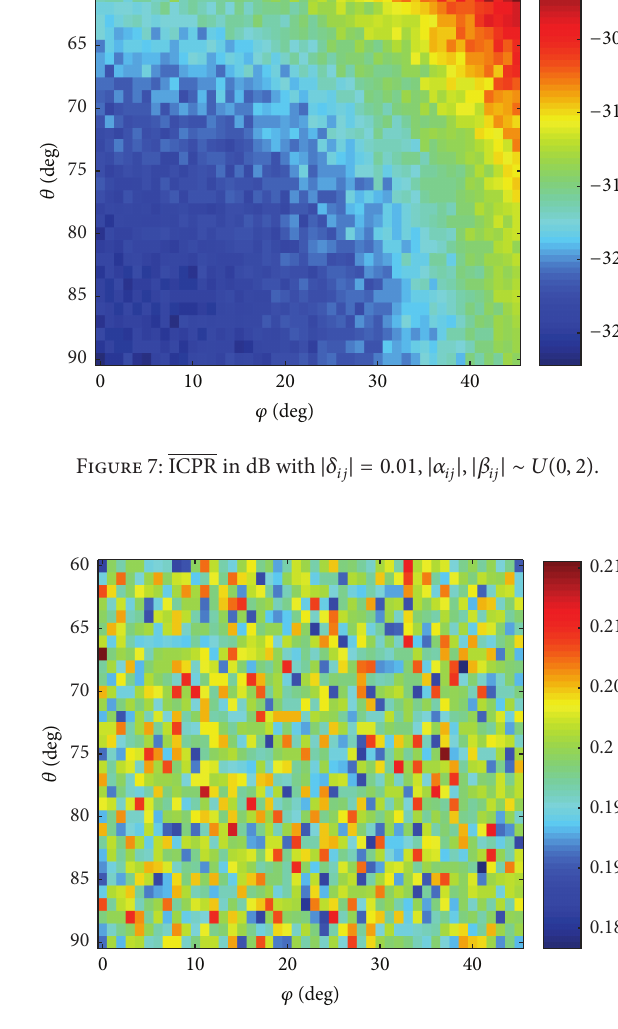
Figure 8: |𝑍 𝑏 DR | in dB with |𝛿 𝑖𝑗 | = 0 . 02, |𝛼 𝑖𝑗 |,|𝛽 𝑖𝑗 | ∼ 𝑈( 0 , 4 ) .